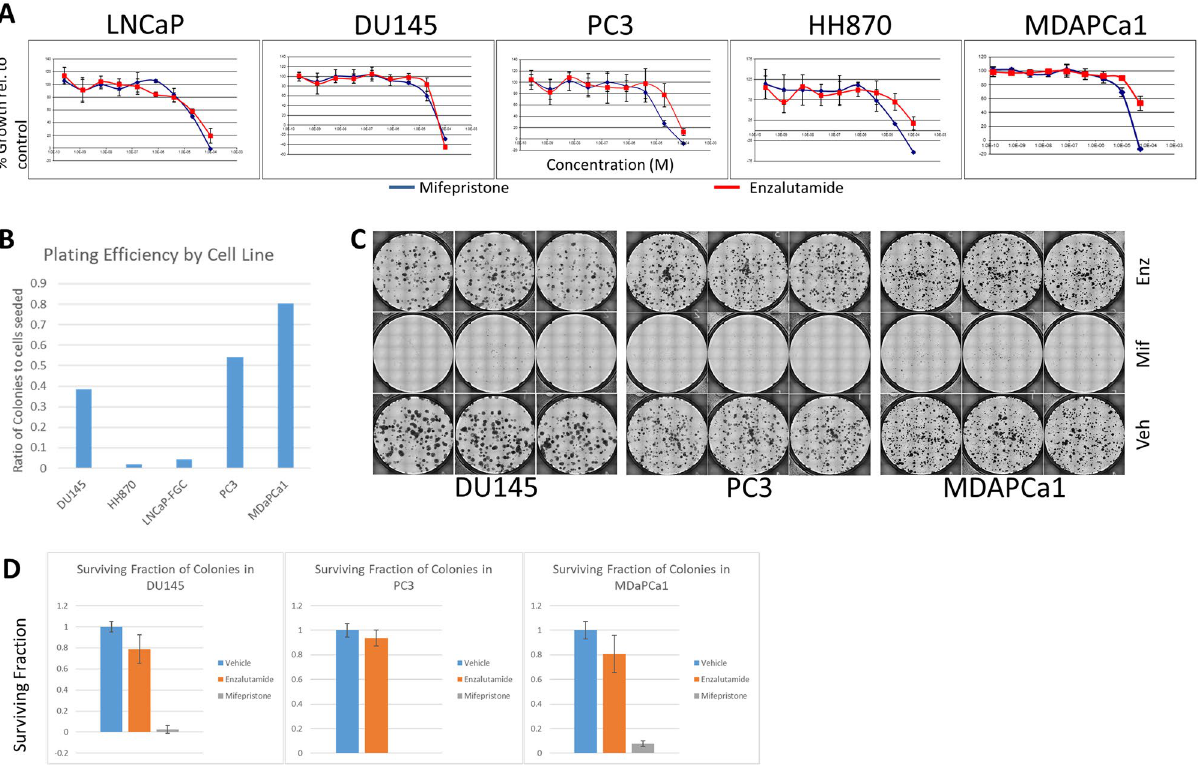
Figure 5. Growth of prostate cancer cell lines treated with enzalutamide versus mifepristone. ( A ) Response of cell lines to enzalutamide (red) or mifepristone (blue) shows that mifepristone is more efficacious in several of the cell lines. ( B ) Assessment of plating efficiency of cell lines used in clonogenic assay testing mifepristone versus enzalutamide response. ( C ) Crystal violet stain for colony formation in DU145, PC3, and MDAPCa1 cells. 25 µM enzalutamide has minimal impact on colony formation in these cells compared to vehicle controls, whereas an equivalent dose of mifepristone almost completely inhibits the ability of these cells to form colonies. ( D ) Quantification of the response to mifepristone and enzalutamide in three AR null cell lines (DU145, PC3, and MDAPrCA1) shows that mifepristone inhibits colony growth more robustly than enzalutamide (at 25 µM